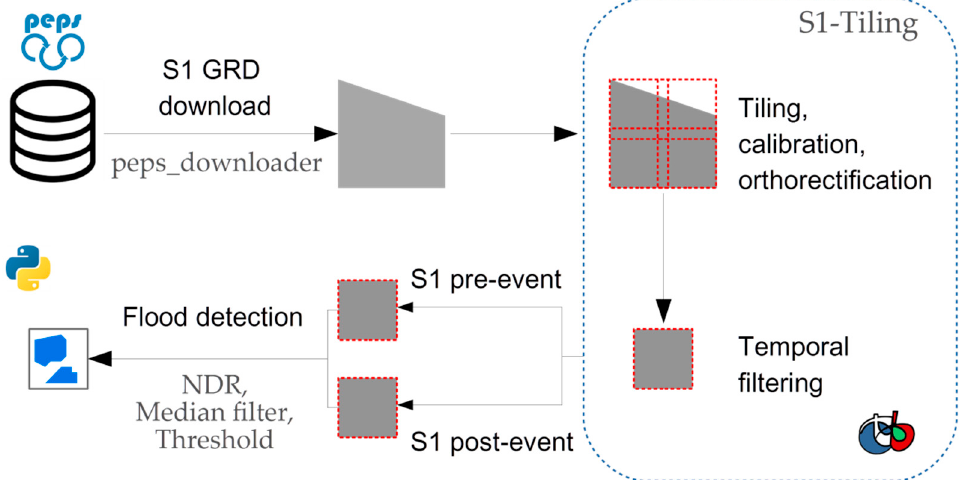
Figure 4. General framework of the processing chain.